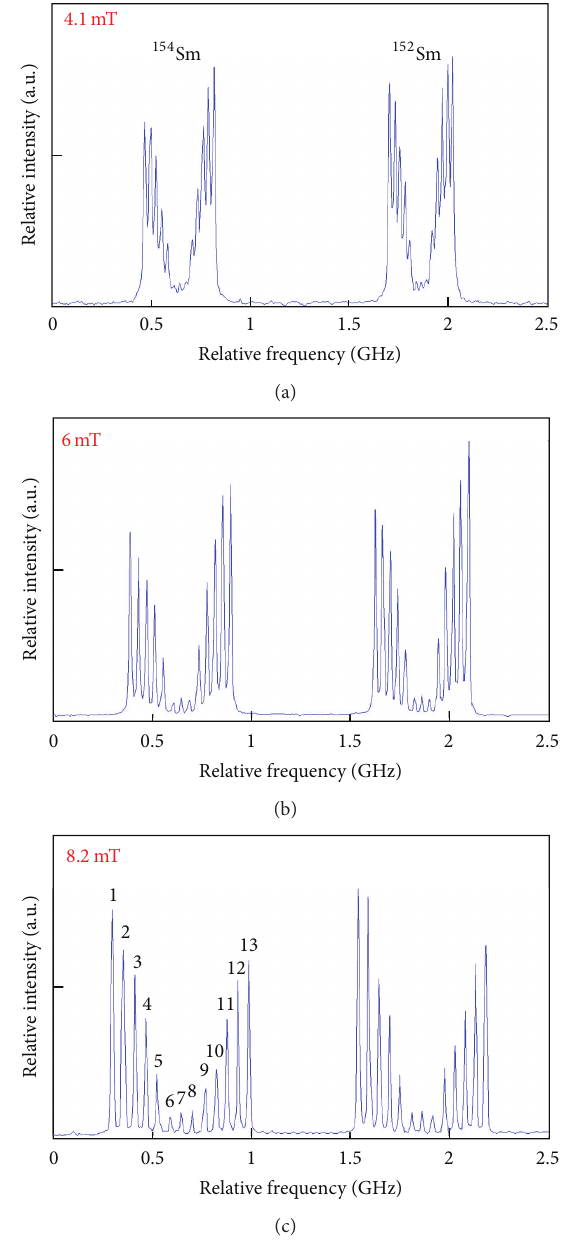
Figure 3: Observed Zeeman spectra of 152 Sm and 154 Sm at the 680.30 nm transition for three magnetic fields. The numbers labeled on peaks correspond to the numbers on Zeeman transitions in Figure